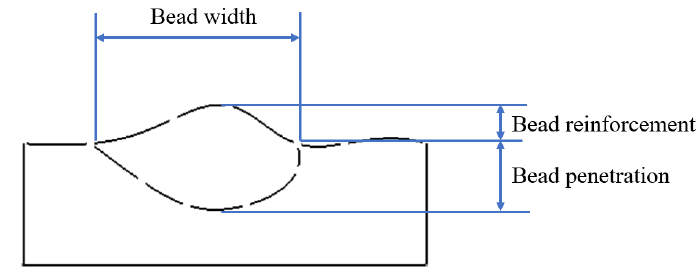
Figure 5. Geometry of weld bead. Table 2. Experimental design and weld bead size for SMAW welding.